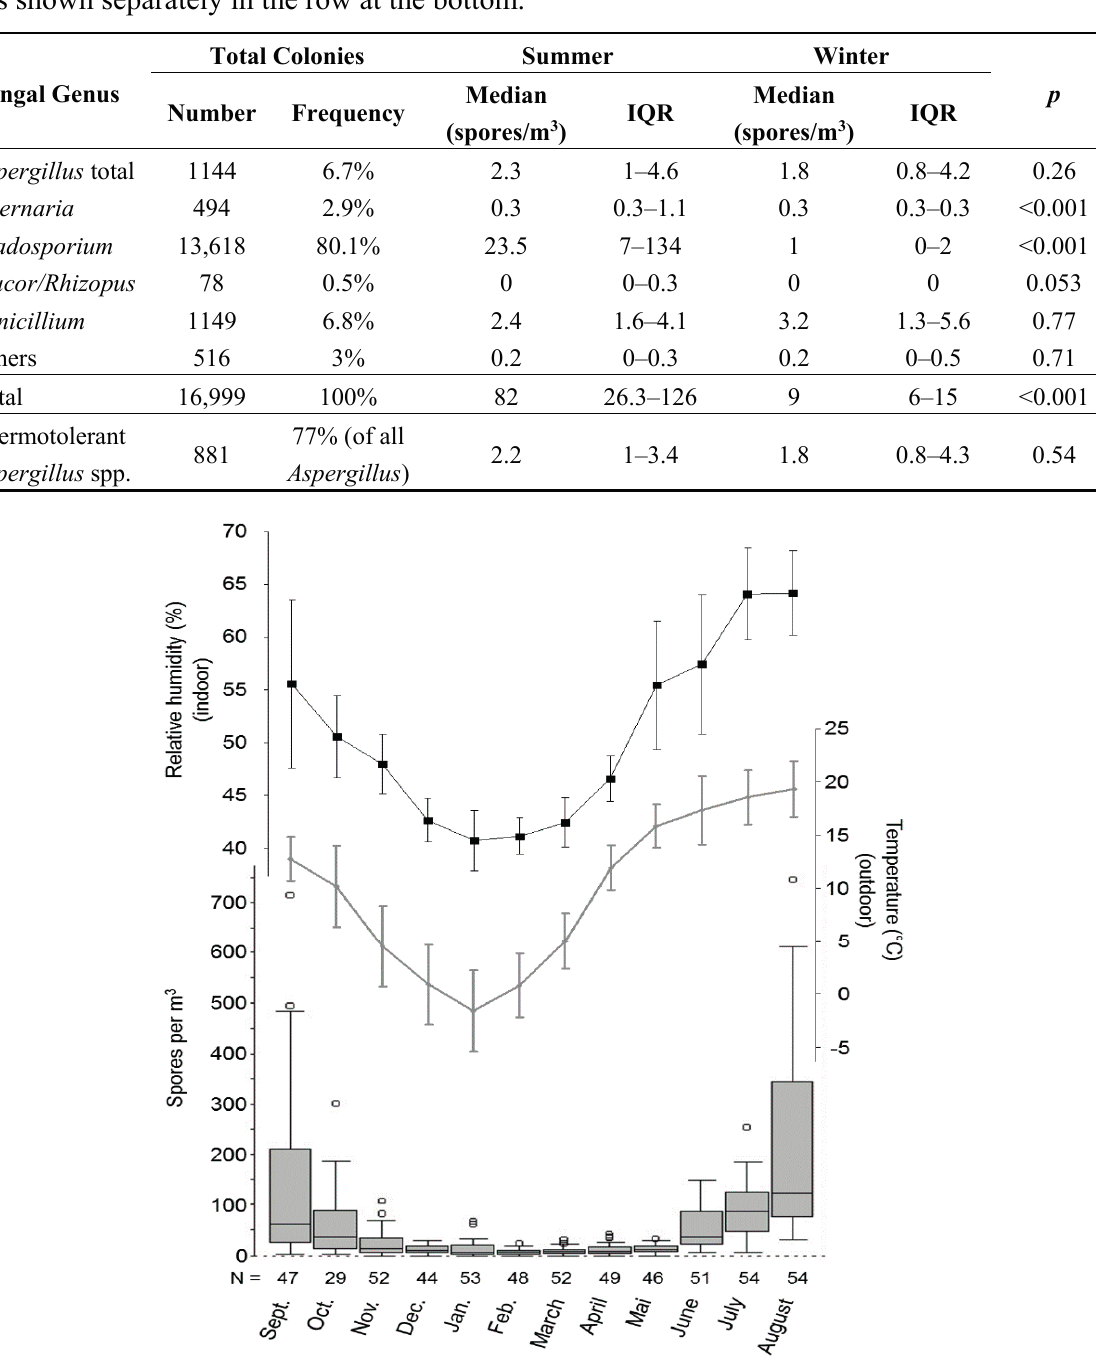
Table 1. Number and frequency of fungal genera (left) and their seasonal medians and inter-quartile range (IQR). Inter-seasonal concentration was compared using Mann-Whitney-U test ( p < 0.05 is considered as significant). Records collected on 5 January 2010, when Christmas trees were removed, are excluded from the analysis. Thermotolerant Aspergillus is shown separately in the row at the bottom.